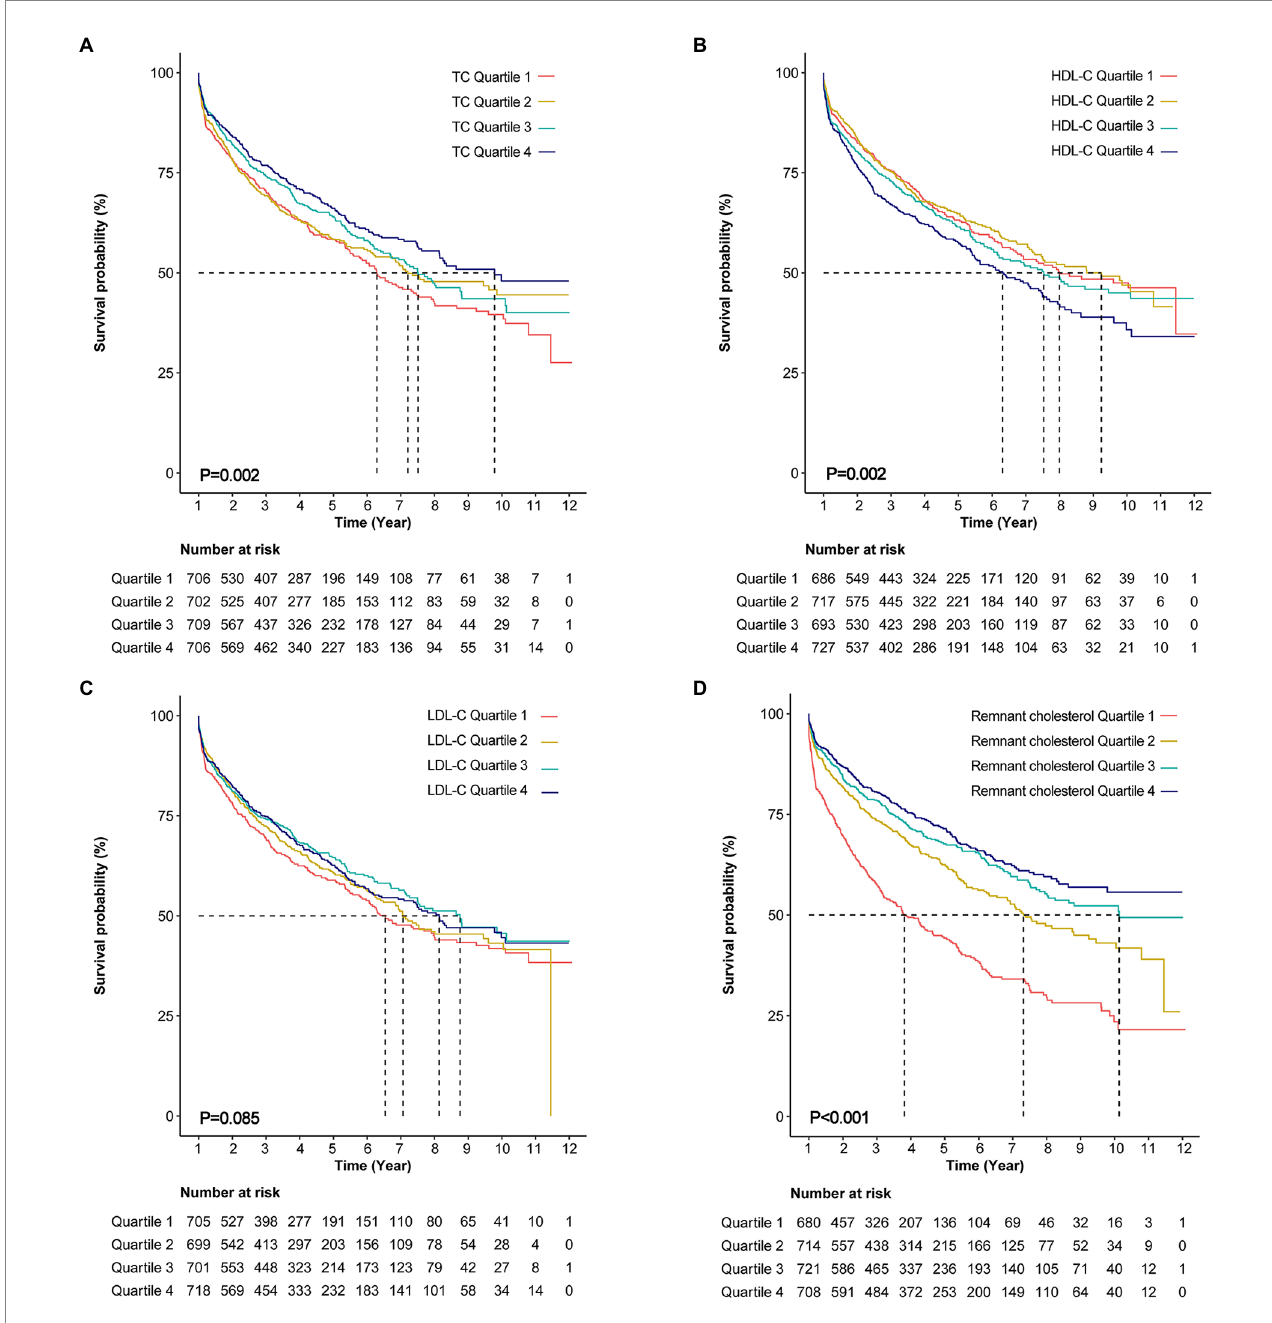
FIGURE 2 Kaplan–Meier curves for all-cause mortality. (A) Kaplan–Meier curves for all-cause death stratified by total cholesterol (TC) quartiles (log-rank, p = 0.002). (B) Kaplan–Meier curves for all-cause death stratified by high density lipoprotein cholesterol (HDL-C) quartiles (log-rank, p = 0.002). (C) Kaplan–Meier curves for all-cause death stratified by low density lipoprotein cholesterol (LDL-C) quartiles (log-rank, p = 0.085). (D) Kaplan–Meier curves for all-cause death stratified by remnant cholesterol (log-rank, p <